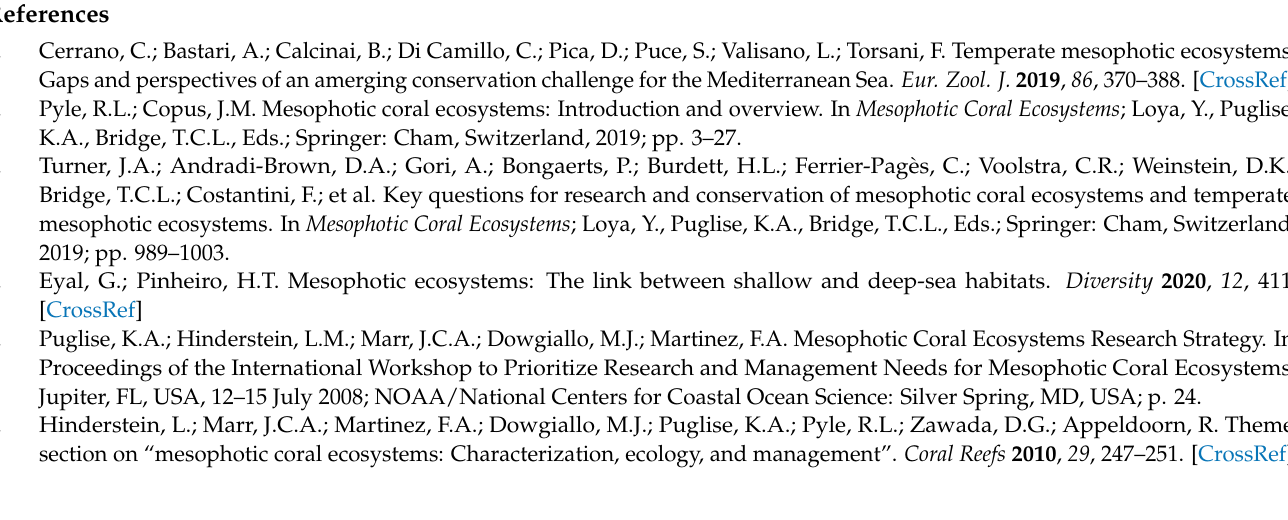
single depth values are single occurrences. Invert.: invertebrates; Figure S3: Species accumulation curves for the four sampled sites: (a) Algarrobo, (b) El Quisco, (c) Las Cruces and (d) Los Vilos; Table S2: Kruskal–Wallis rank sum test for the density of fish species and trophic categories between depth strata: <20 m (N = 33), 20–40 m (N = 44), 40–60 m (N = 27), >60 m (N = 16). Only species with more than two occurrences on each depth section (N = 120) are included, while all recognised fish taxa were grouped in trophic categories. p -values < 0.05 are highlighted in bold; Table S3: Pairwise comparison of fish species and trophic categories that showed a significantly different density among depth bands (<20 m, 20–40 m, 40–60 m, >60 m) using a Bonferroni ´ s correction. p -values < 0.05 are highlighted in bold; Table S4: Pairwise comparison of the fish community across sites using PERMANOVA (999 permutations). p -values < 0.05 are highlighted in bold; Table S5: Permutation test for homogeneity of multivariate dispersions on the fish community across sites. Table S6: Kruskal–Wallis rank sum test for the percentage cover data between depth bands: <20 m (N = 73), 20–40 m (N = 109), 40–60 m (N = 47), >60 m (N = 8). p -values < 0.05 highlighted in bold. Inverteb: invertebrates; Table S7: Pairwise comparison of the percentage cover data that showed a significantly different abundance between depth bands (<20 m, 20–40 m, 40–60 m, >60 m) using a Bonferroni ´ s correction. p -values < 0.05 are highlighted in bold; Table S8: Pairwise comparison of the percent cover data across sites using PERMANOVA (999 permutations). p -values < 0.05 are highlighted in bold. Table S9a: Permutation test for homogeneity of multivariate dispersions on the percent cover data of the benthic community across sites. p -value < 0.05 highlighted in bold; Table S9b: Pairwise comparison for homogeneity of multivariate dispersions on the percent cover data of the benthic community across sites. Observed p -value below diagonal, permuted p -value above diagonal. p -values < 0.05 in